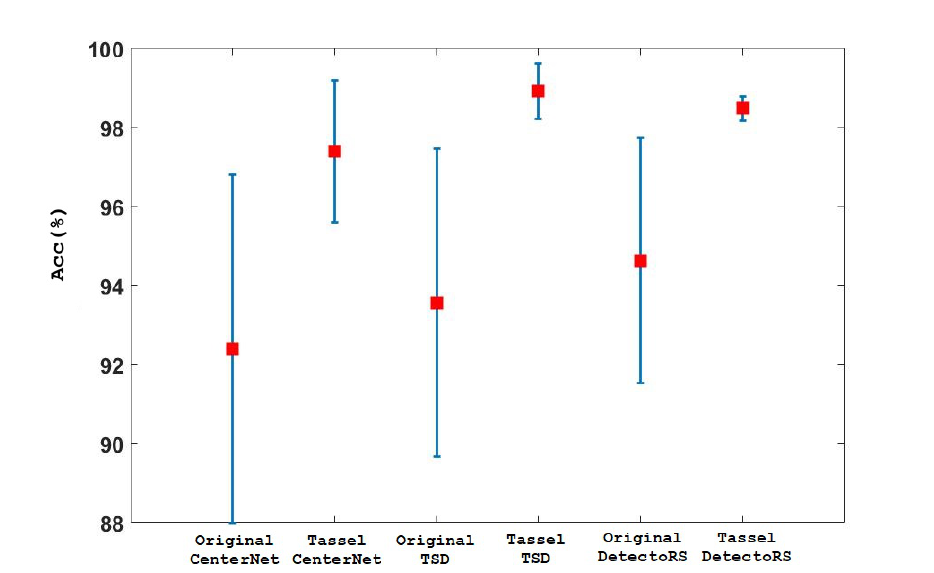
Figure 9. Comparison of original and developed tassel detection